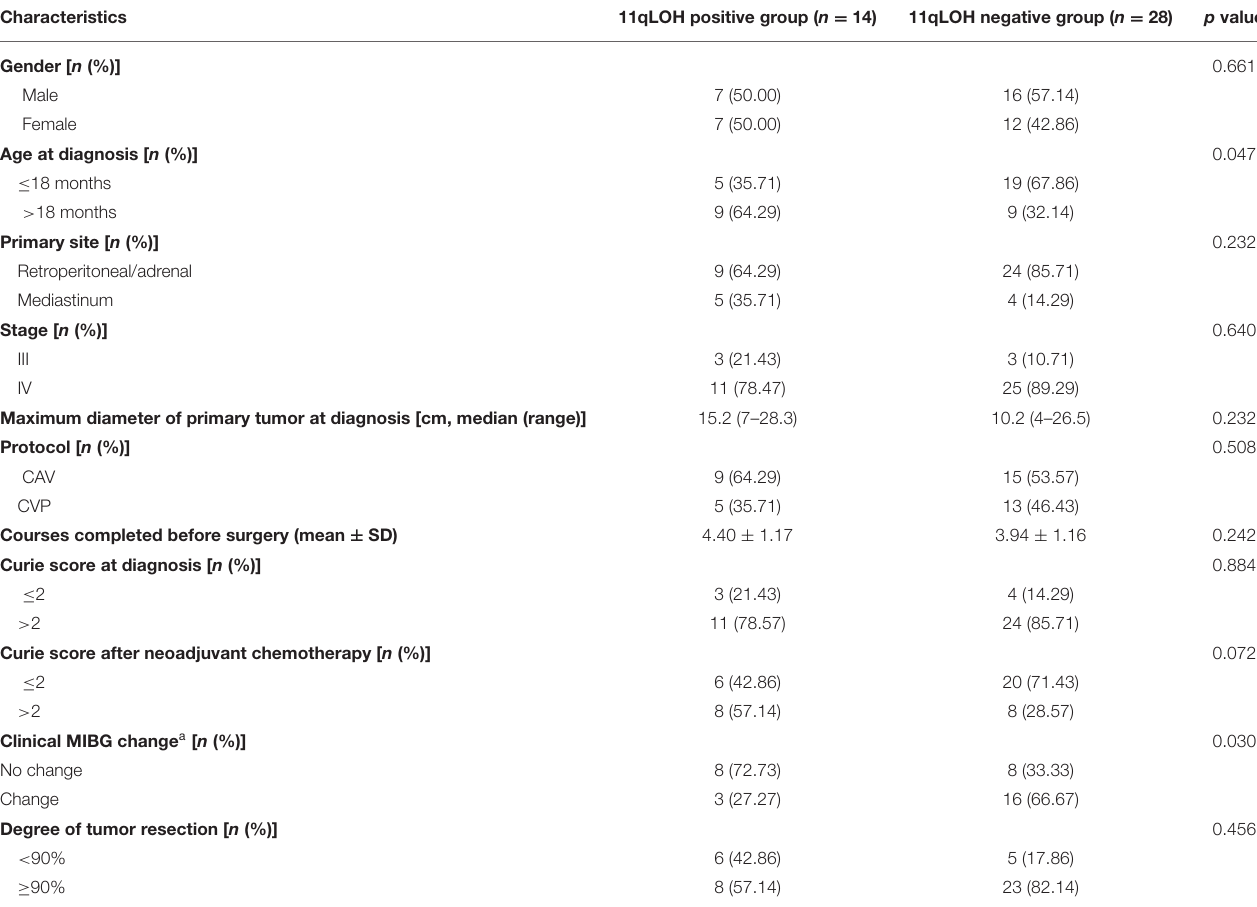
TABLE 1 | Clinical characteristics of the 42 patients with MYCN amplification. Characteristics